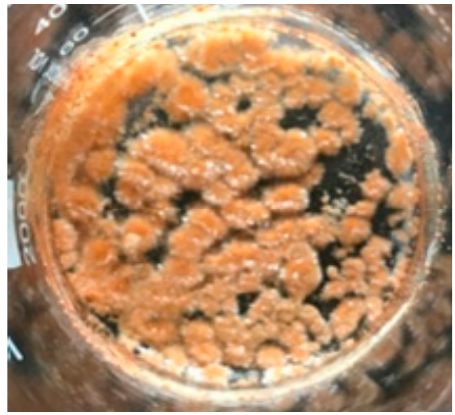
Figure 1. Titled compound 3c after recrystallization with methanol.